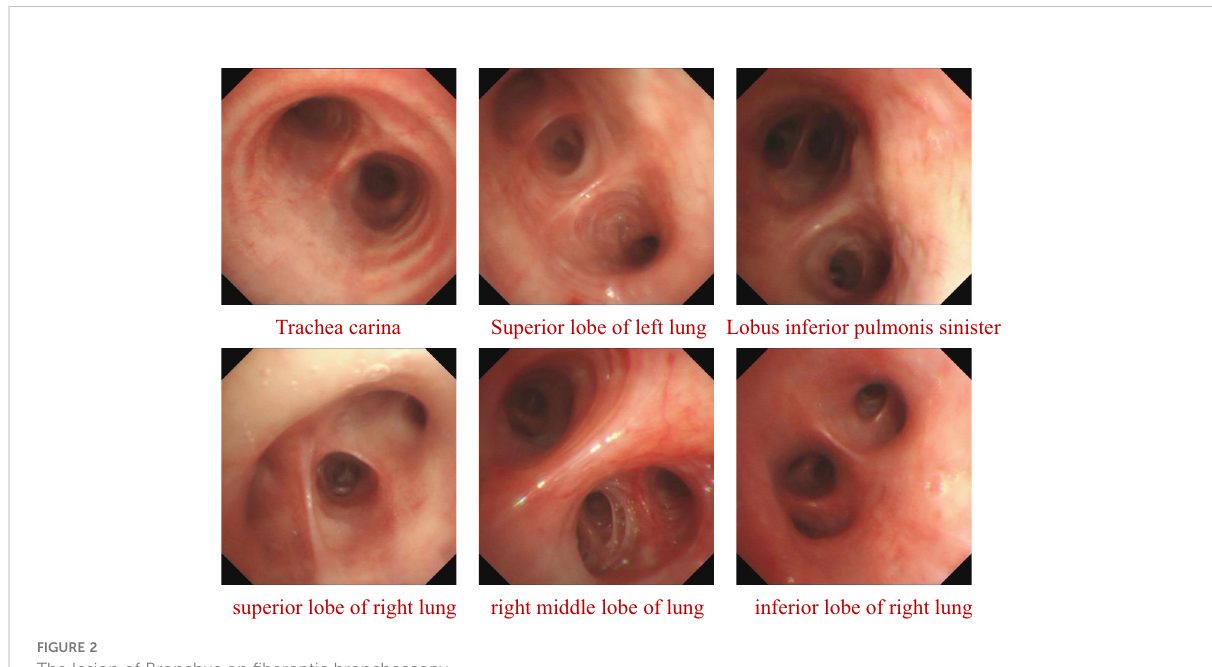
FIGURE 2 The lesion of Bronchus on fi beroptic